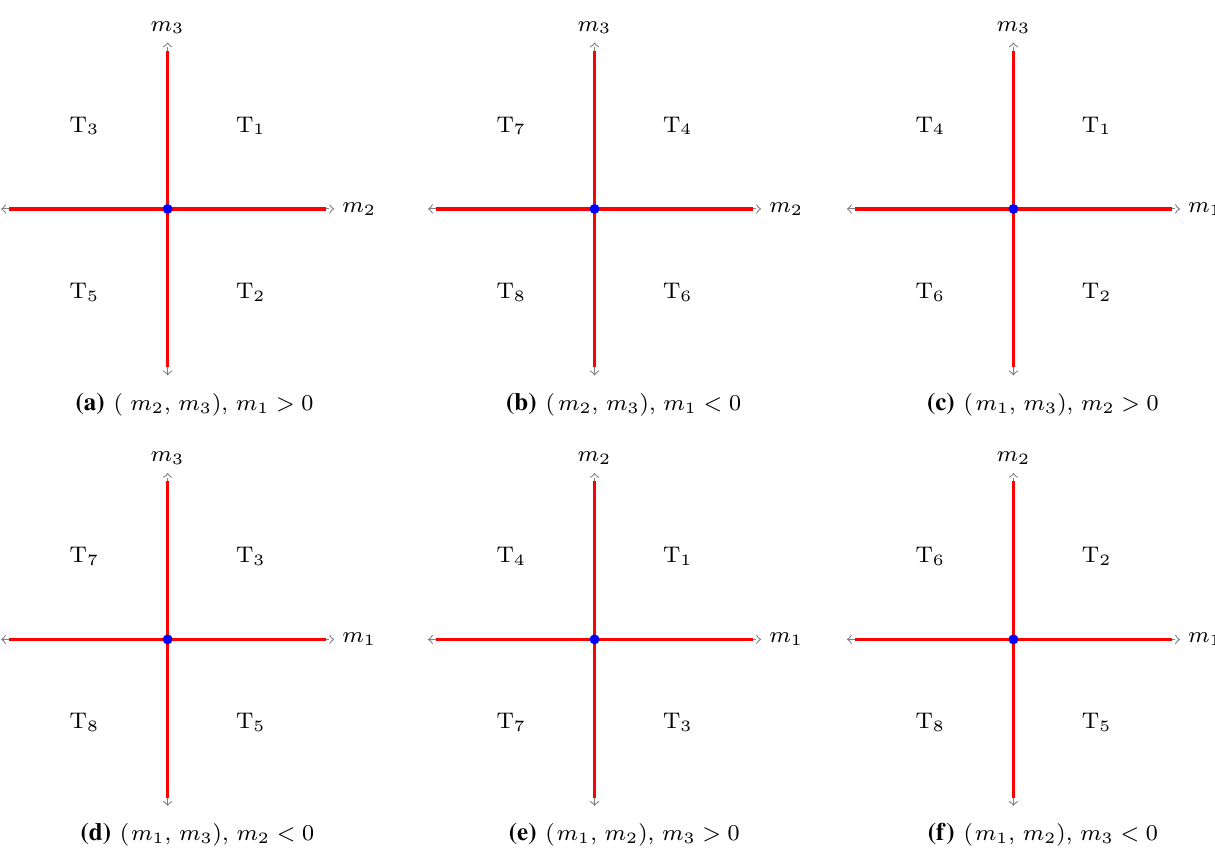
Fig. 4 Phases of SU ( N ) k + p ψ 1 + q ψ 2 + ( F − p − q )ψ 3 with k ≥ F /